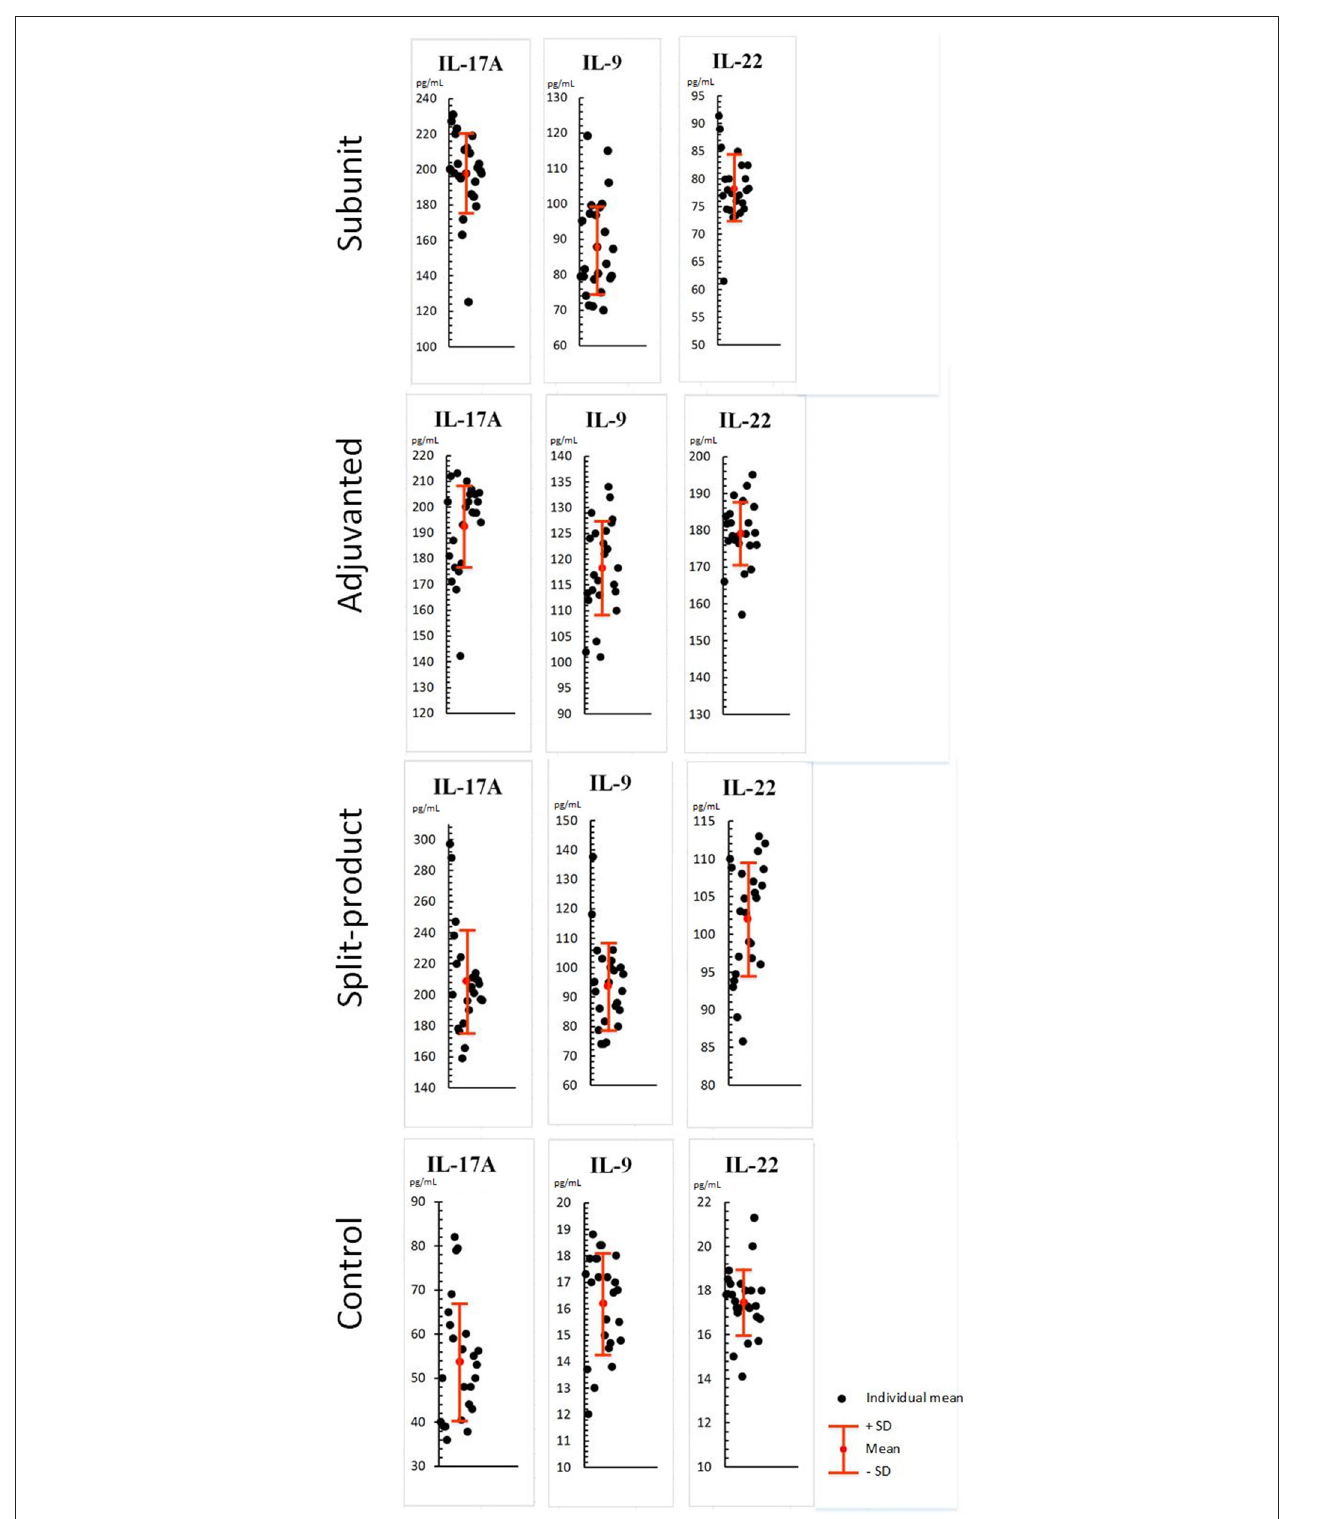
FIGURE 3 | Effect of vaccines against influenza on Th-17/Th-9/Th-22 cytokine levels in PBML culture. PBML were isolated from peripheral blood. Cytokine level in PBML supernatants was determined 24h after incubation with vaccines against influenza by flow cytometry. All data are shown as individual means, M (mean values) ± SD (standard deviation). The significance of differences between mean values at each time point was tested by Mann–Whitney rank sum tests for independent samples ( P ≤ 0.05).